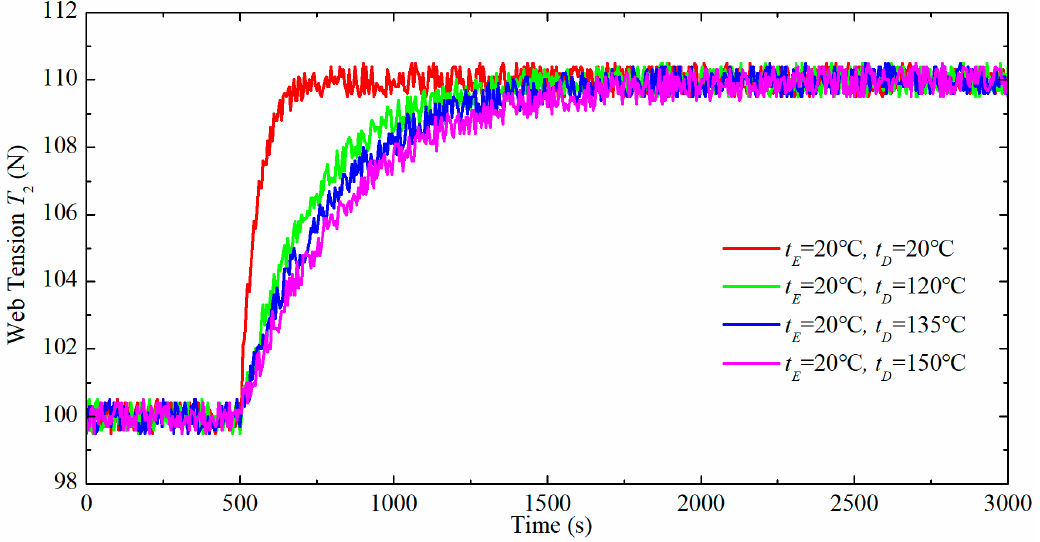
( ) T t as ( ) T t has step changes at different drying 2 1